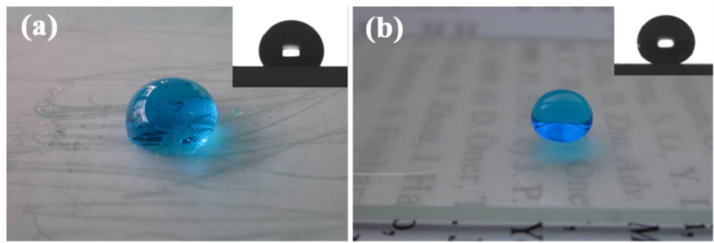
Figure 5. Photographs of a water droplet on the surface partly destroyed by mechanical scratching ( a ) and on the regenerated surface by immersion in TiO 2 nanowire suspension and drying again ( b ). ( b ). Insets in ( a , b ) are the profiles of a water droplet with CA value 118 ◦ ± 1 ◦ and 155 ◦ ± 1 ◦ . Insets in ( a , b ) are the profiles of a water droplet with CA value 118° ± 1° and 155° ± 1°. Reprinted from Reprinted from [77] with permission; Copyright Elsevier [77] with permission; Copyright Elsevier 2013.